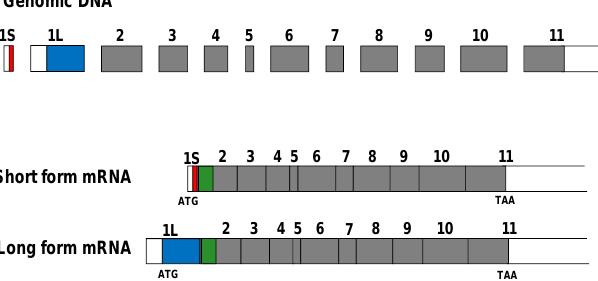
Figure 2. Structure of the genomic DNA and the two major B4GALNT2 transcripts. Both the alternative exons 1S and 1L contain a translational start codon. Their coding portion is indicated in red and blue, respectively. Coding portions common to the two transcripts are in grey. The transmembrane portion is in green. Exons are drawn approximately to scale.